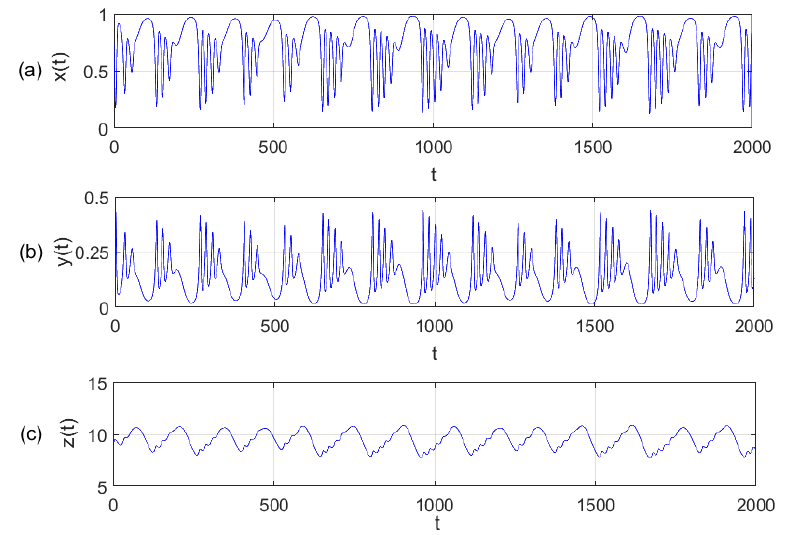
Figure 2. Time-domain waves of system (4). ( a ) x ( t )- t ; ( b ) y ( t )- t ; ( c ) z ( t )- t .